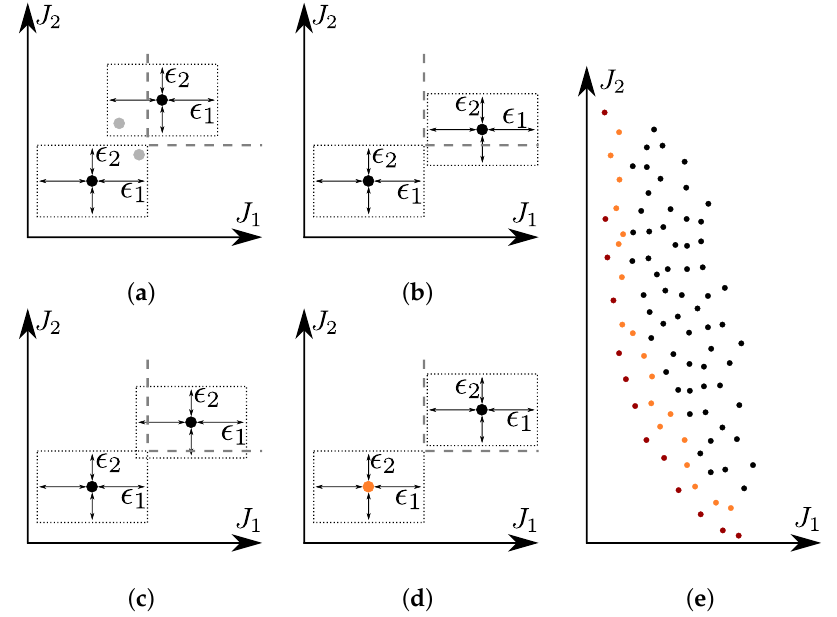
Figure 2. Example for the (cid:101) -dominance property. A point-wise comparison is illustrated in ( a )–( d ). The uncertainties are marked by the dashed boxes. Only in case ( d ), the lower left point confidently dominates the other point. In ( e ), the entirety of Pareto fronts for the exact problem ( P F ) and the inexact problem ( P F , (cid:101) ) are shown in red and orange, respectively.